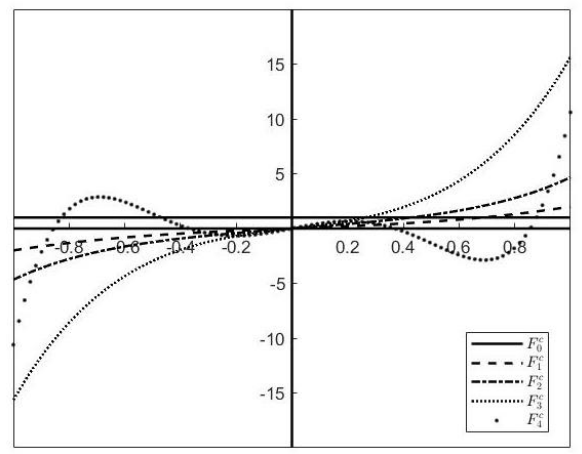
Figure 2. Odd Fibonacci-central factorial